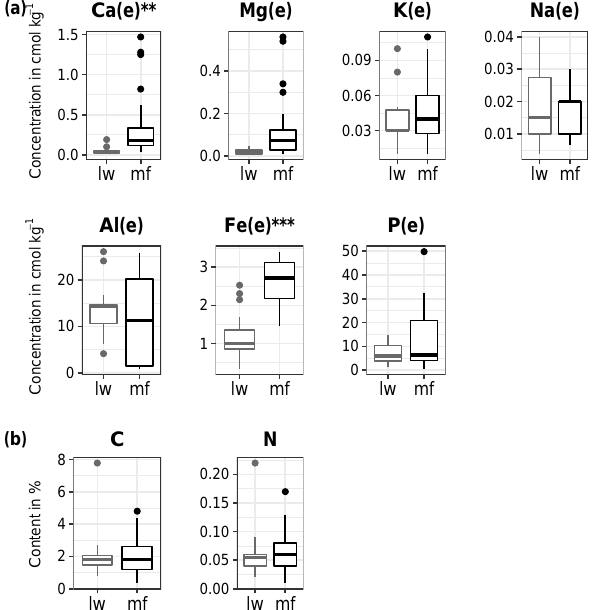
Figure 4. Distribution of chemical compounds in the B horizon in lichen woodland and moss forest plots (lw and mf, respec- tively). (a) Concentrations of exchangeable base cations and ex- tractable P, (b) organic C and N. Boxplots represent the distribu- tion around the median values. “(e)” indicates exchangeable or ex- tractable elements. Asterisks indicate a significant difference using mixed models (see Materials and methods), with ∗ p value<0.05, ∗∗ p value<0.01 and ∗∗∗ p value<0.001.